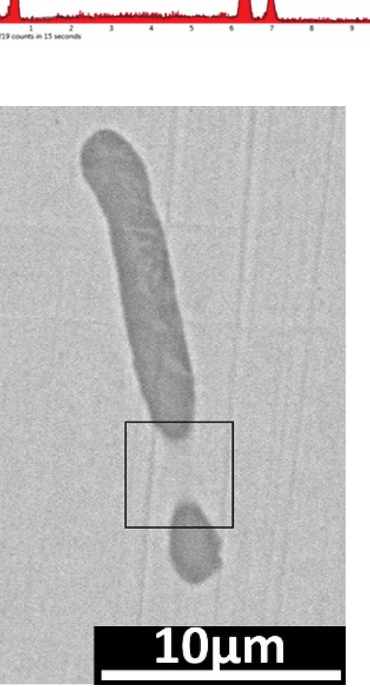
Figure 9: Component analysis of point 1 at 35 s of corrosion.